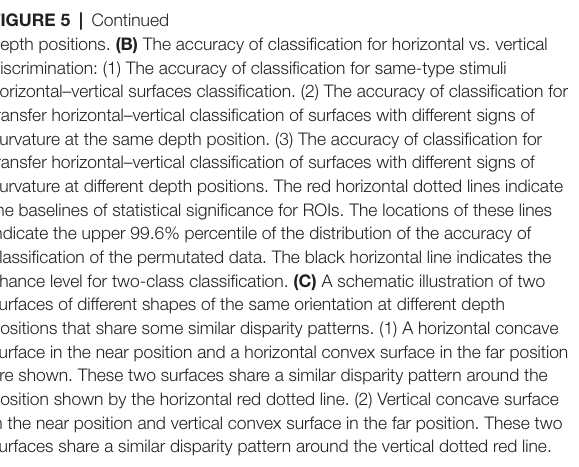
FIGURE 5 | Continued depth positions. (B) The accuracy of classification for horizontal vs. vertical discrimination: (1) The accuracy of classification for same-type stimuli horizontal–vertical surfaces classification. (2) The accuracy of classification for transfer horizontal–vertical classification of surfaces with different signs of curvature at the same depth position. (3) The accuracy of classification for transfer horizontal–vertical classification of surfaces with different signs of curvature at different depth positions. The red horizontal dotted lines indicate the baselines of statistical significance for ROIs. The locations of these lines indicate the upper 99.6% percentile of the distribution of the accuracy of classification of the permutated data. The black horizontal line indicates the chance level for two-class classification. (C) A schematic illustration of two surfaces of different shapes of the same orientation at different depth positions that share some similar disparity patterns. (1) A horizontal concave surface in the near position and a horizontal convex surface in the far position are shown. These two surfaces share a similar disparity pattern around the position shown by the horizontal red dotted line. (2) Vertical concave surface in the near position and vertical convex surface in the far position. These two surfaces share a similar disparity pattern around the vertical dotted red